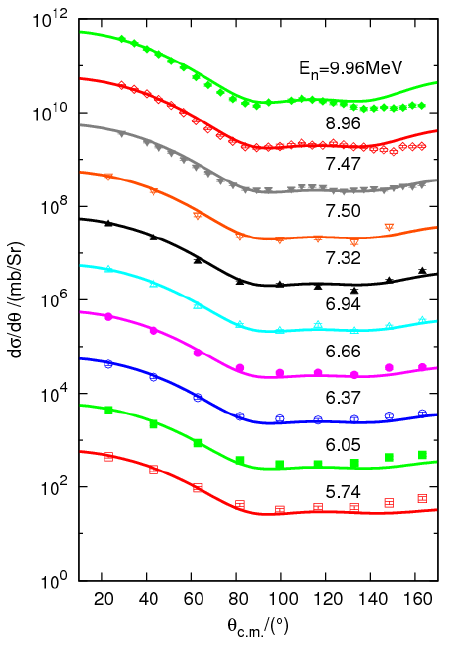
Fig. 5. The angular distributions of the n+ 6 Li elastic scattering reactions at E n =5.74, 6.05, 6.37, 6.66, 7.32, 7.5, 7.47, 8.96, 9.96 MeV. The solid lines for the R-matrix calculations, and the dots are experiment data in EXFOR [13].